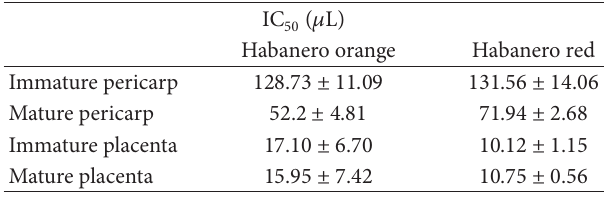
Table 1: IC values of pericarps and placentas from two C. chinense 50 Jacq. accessions at different maturation